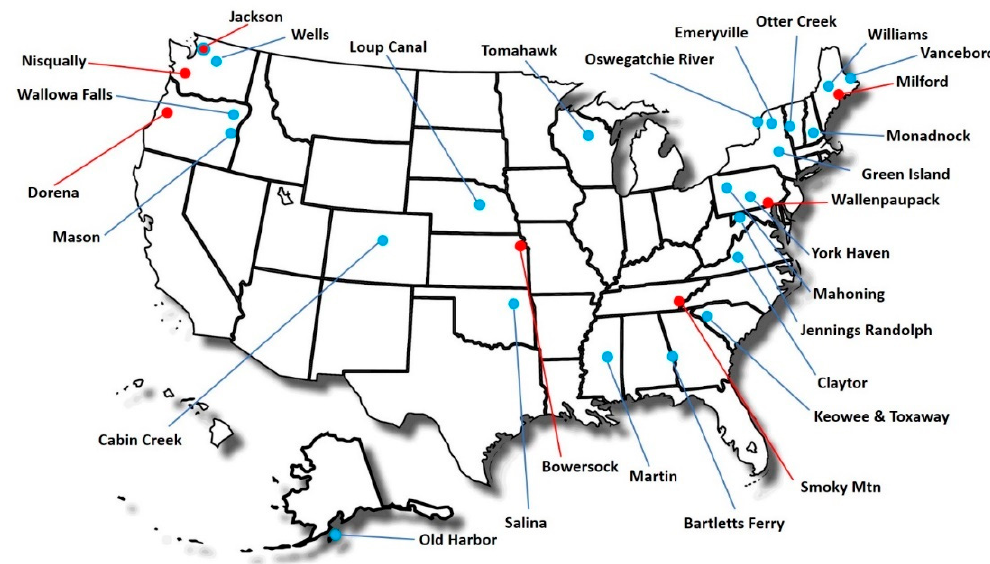
Figure 1. Map of all 29 project locations. Blue dots indicate the 23 projects assessed for Dataset 1 using study determination letters. Red dots indicate the seven projects studied in detail for Dataset 2. Note that Jackson has a red dot with a blue outline because it is included in both datasets.